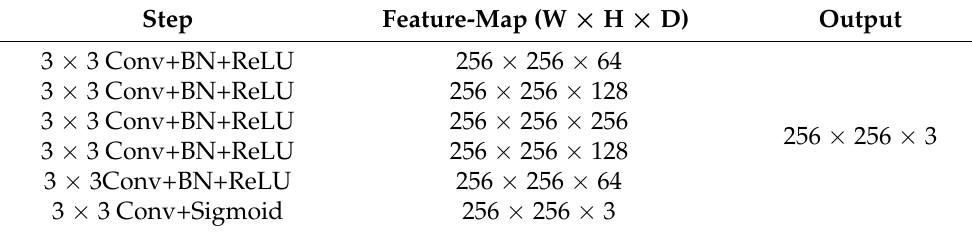
Table 2. Revealing Network